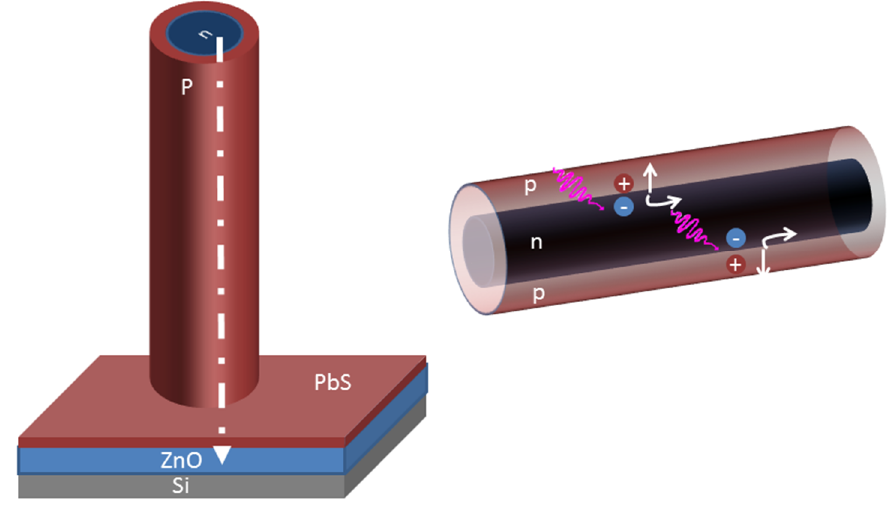
Figure 3. Illustration of ZnO nanowires decorated with PbS NPs forming a radial junction.